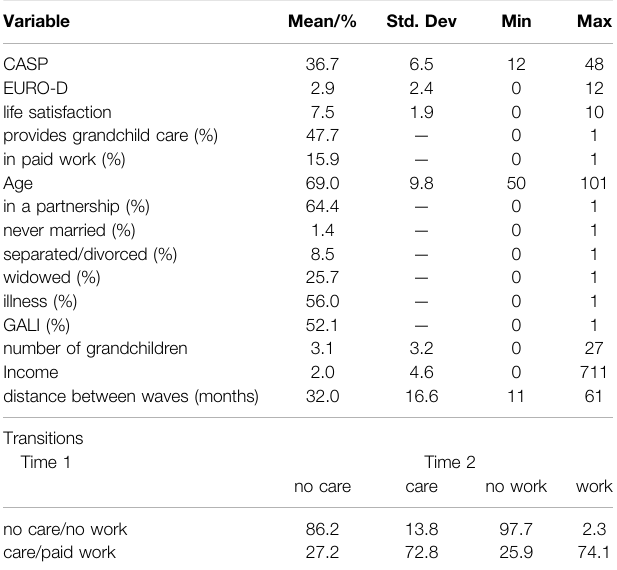
TABLE 1| Descriptive statisticsfor allvariables used intheregressionmodels and transition rates for the explanatory variables.